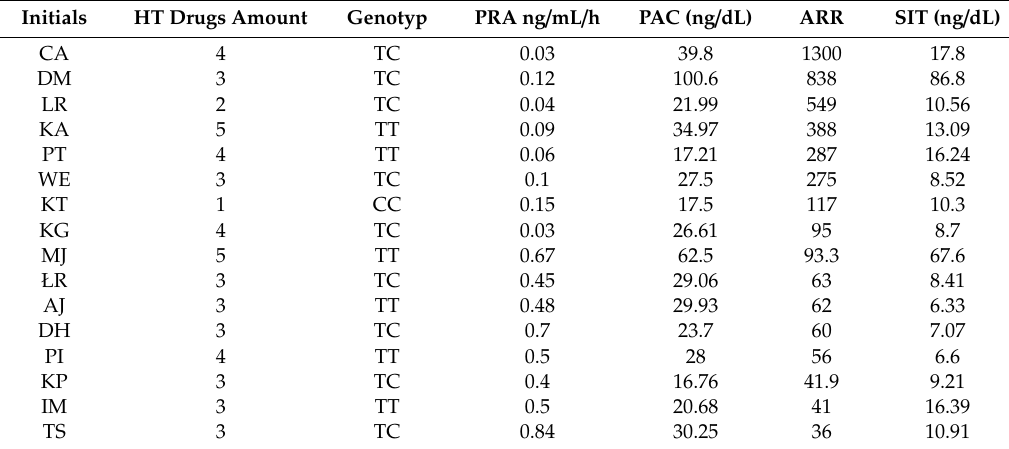
Table 3. Characteristics of patients with primary